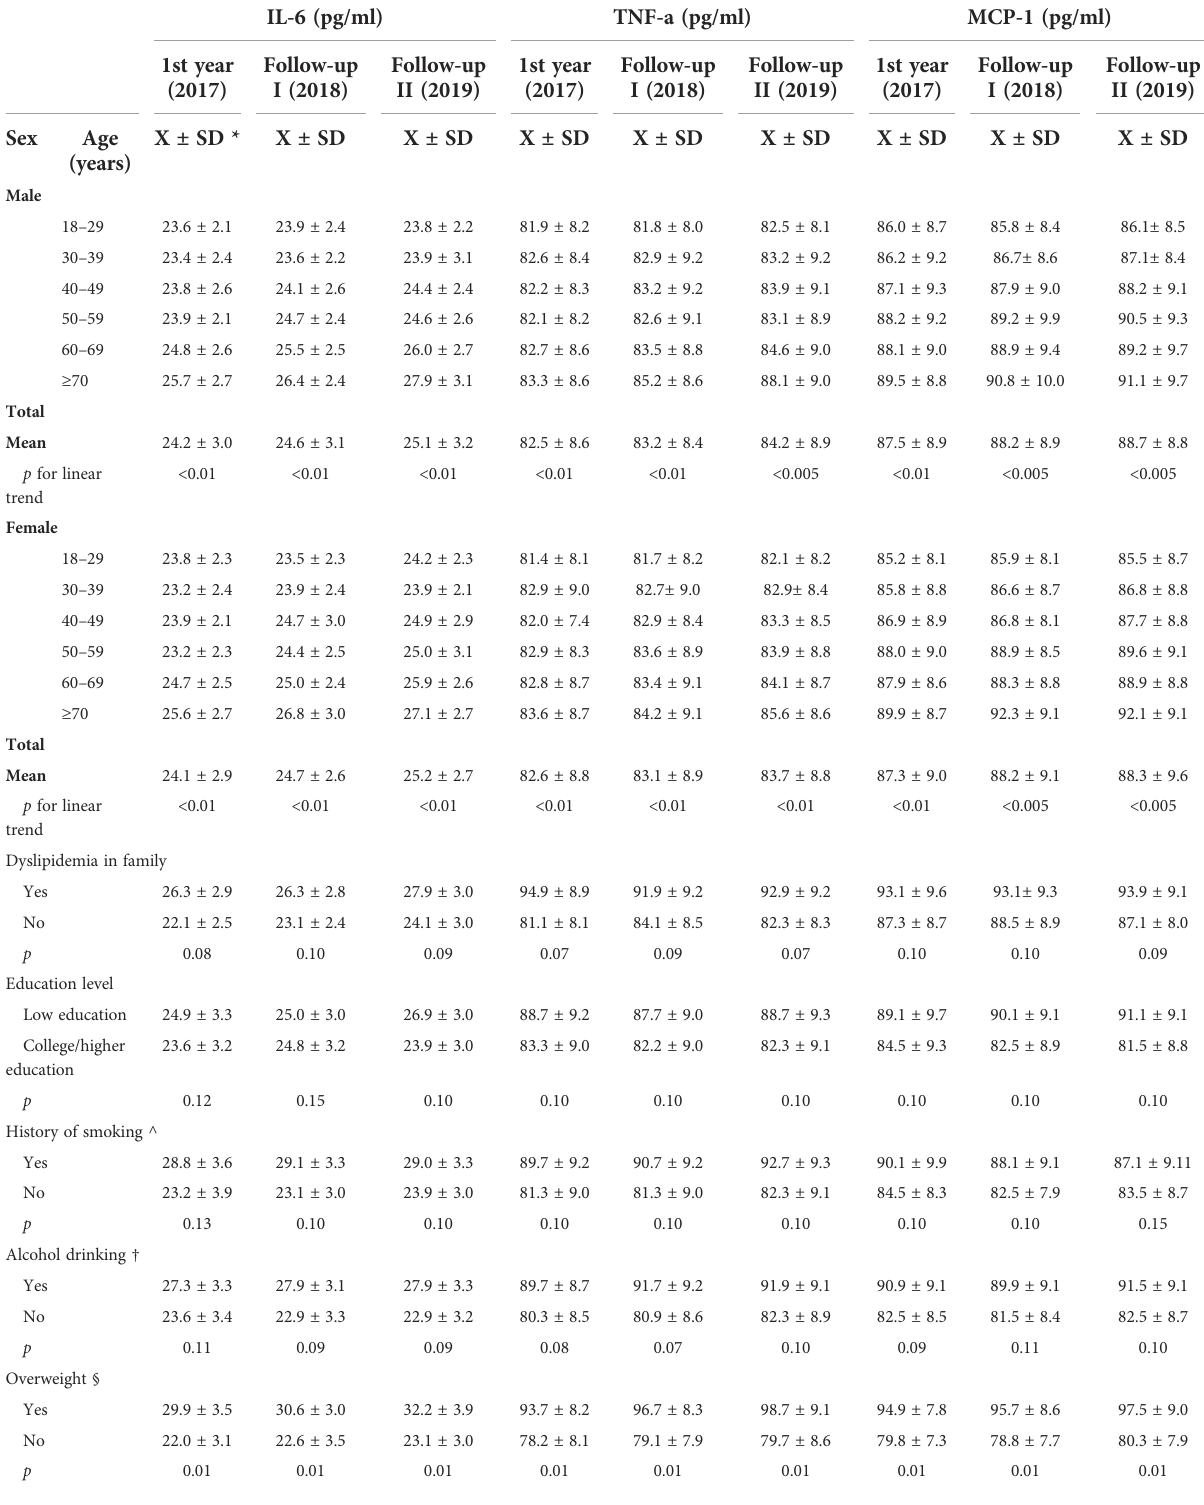
TABLE 5 The serum levels of proin fl ammatory cytokines according to demographic and socioeconomic variables among adults in East Coast, Fujian, China. Serum in fl ammatory